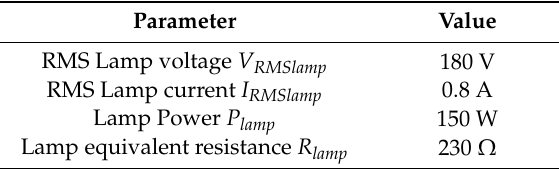
Table 1. Electrical parameters of the EFL lamp used.